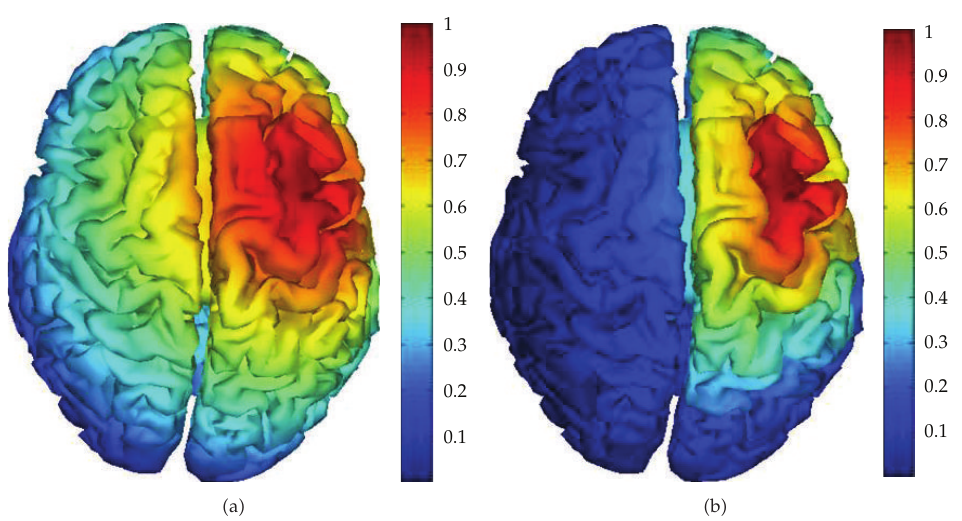
Figure 2: One column of (cid:2) a (cid:3) Euclidean and (cid:2) b (cid:3) geodesic weighted matrix visualized on the cortical surface.